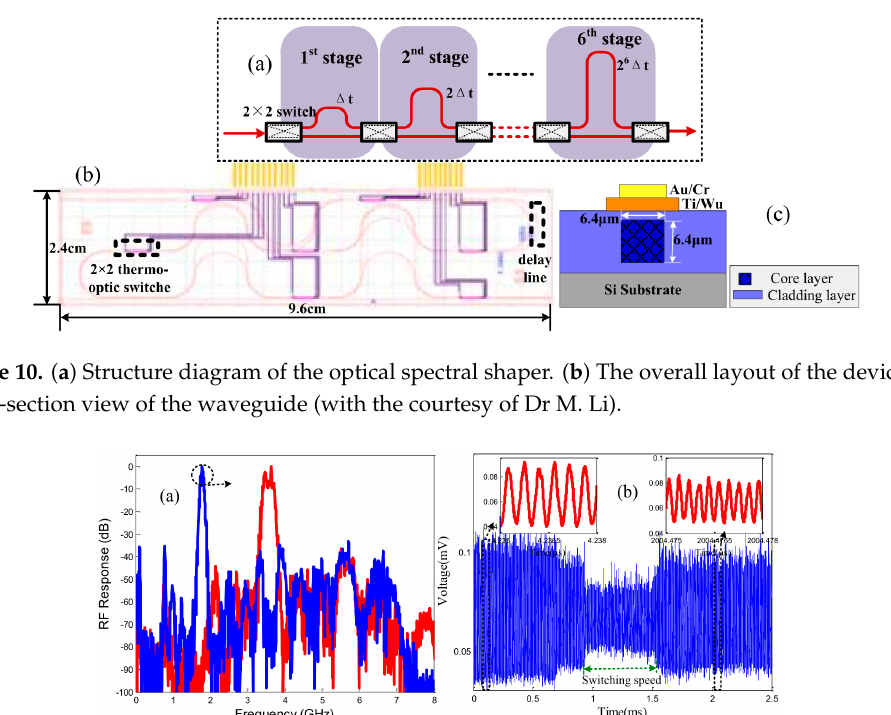
Figure 11. ( a ) Measured frequency response of the single passband microwave photonic filter based on an integrated optical spectral shaper. ( b ) Temporal waveform of the generated frequency-hopping signal, inset: zoom-in view of the two hopping frequencies (with the courtesy of Dr M. Li).